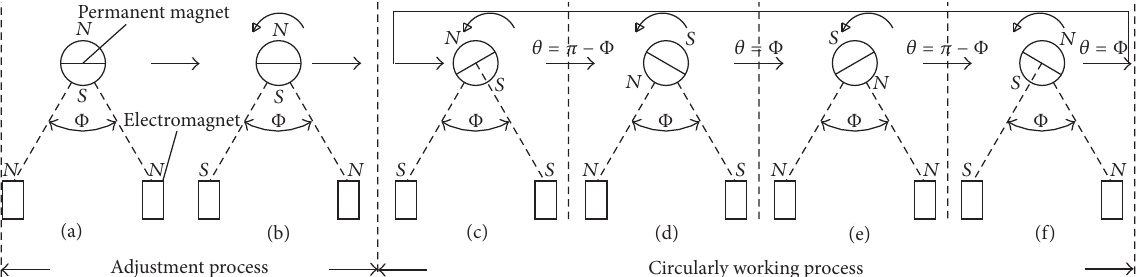
Figure 3: Principle of rotation of the passive permanent magnet.